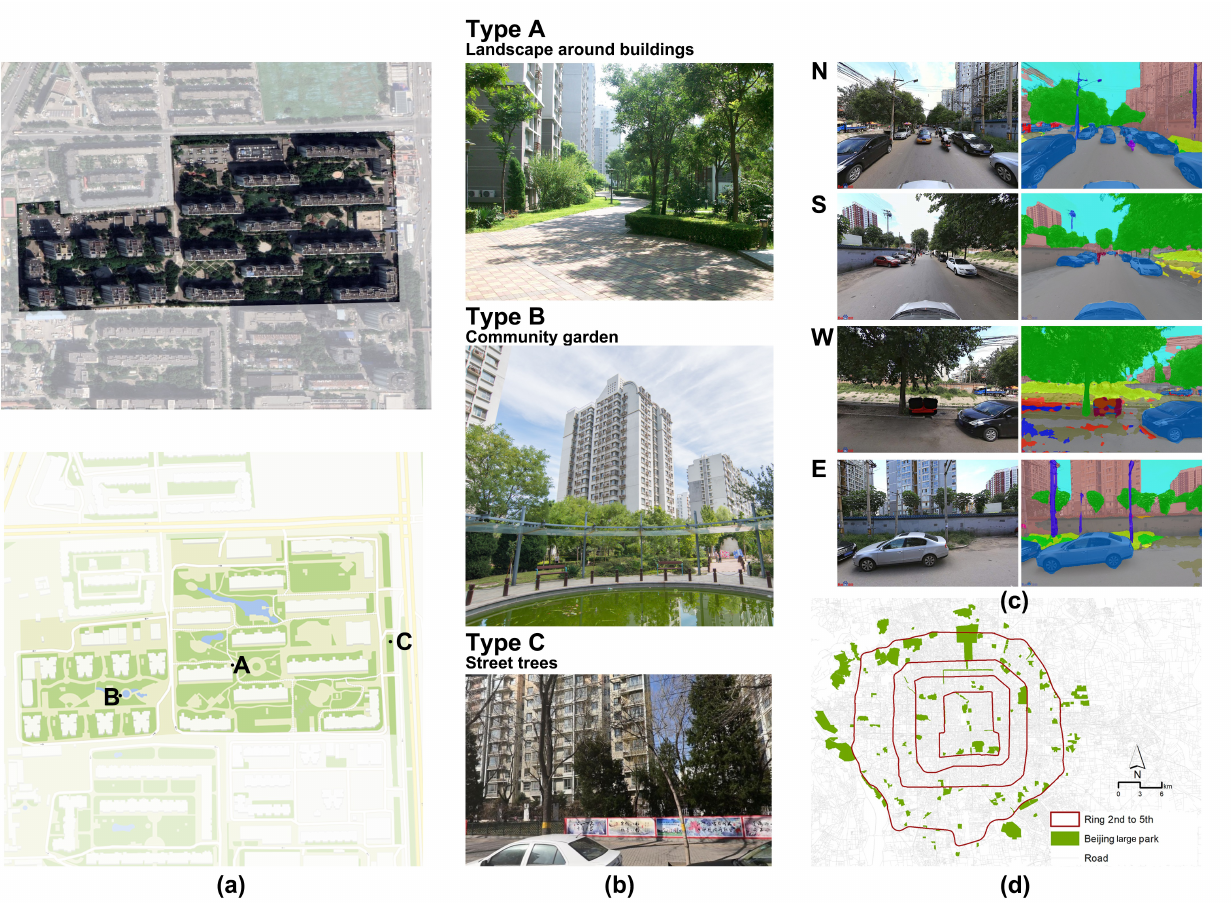
Figure 2. Data sources: ( a ) Green spaces in the communities from Bigemap, ( b ) types of green spaces in the communities, ( c ) green spaces seen in Baidu street view images, ( d ) large parks surrounding the communities from